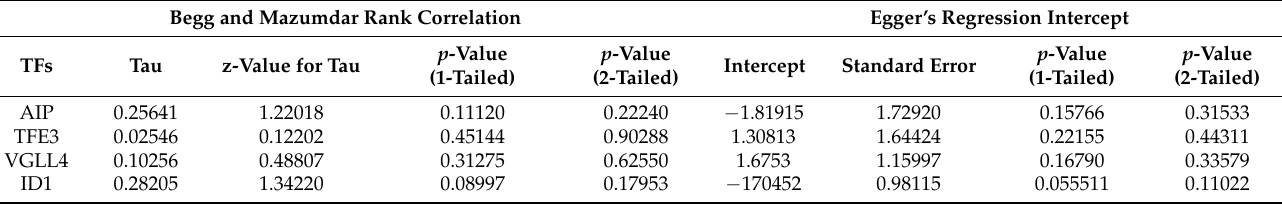
Table 3. Prediction bias indices for each signature